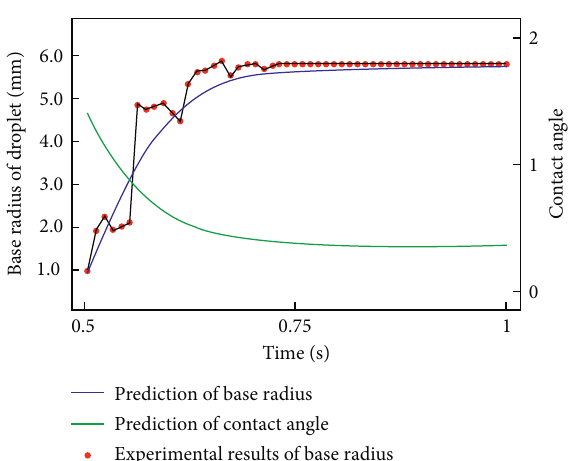
Figure 14: Variation of droplet base radius in spreading stage (wire feed speed is 5.0m/min).